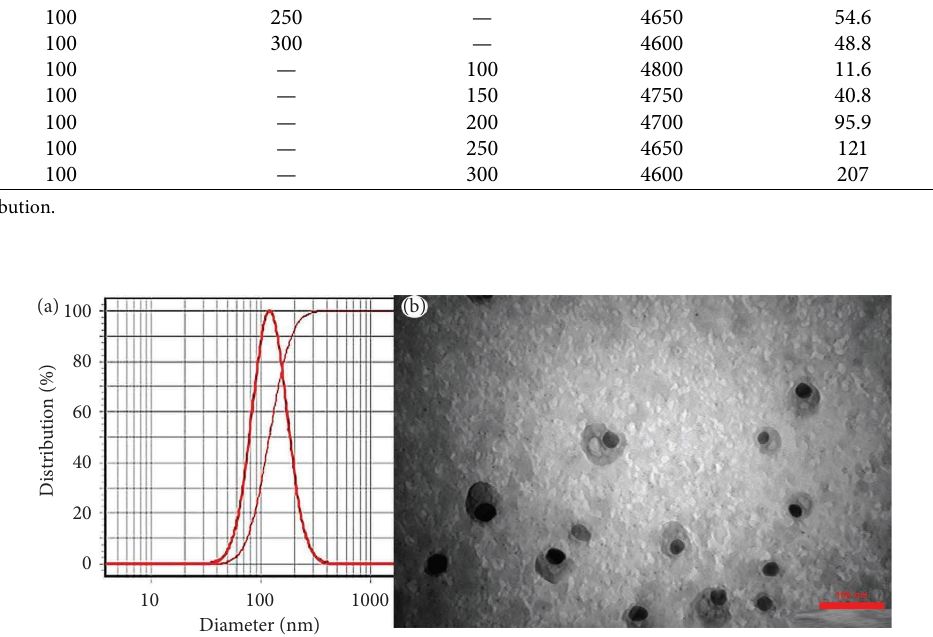
Figure 1: (a) Optimal nanoemulsion with a droplet size of 121 ± 3 nm and (b) TEM image (scale bar � 100nm).